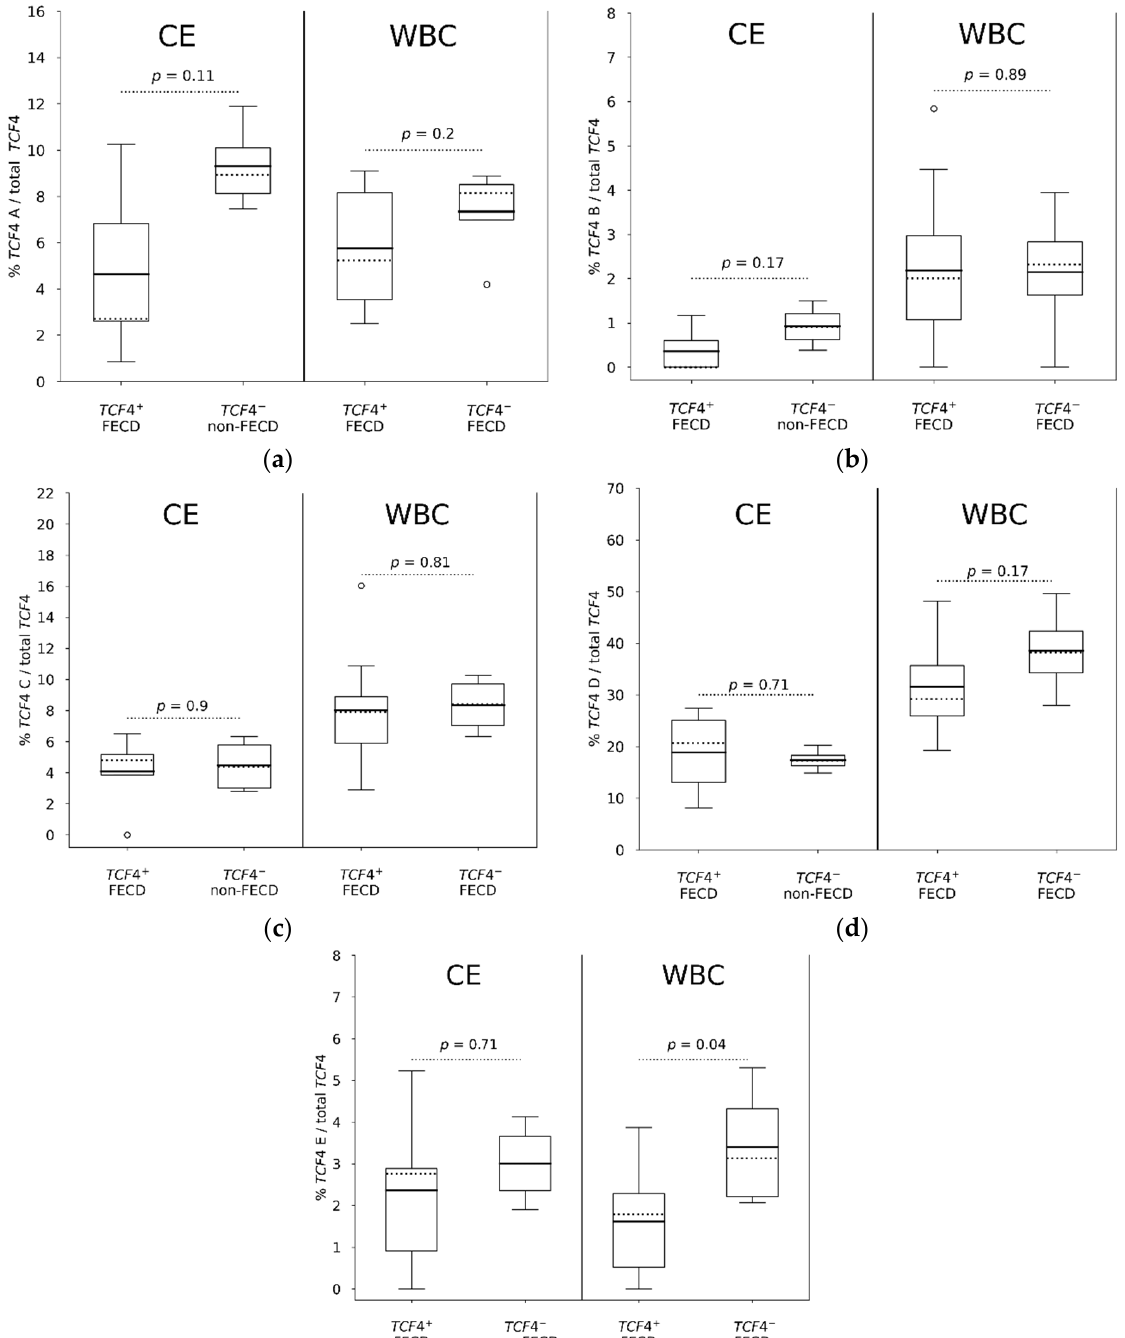
Figure 4. mRNA gene expression probed by TaqMan TM assays A to E in corneal endothelium and WBC targeting TCF4 transcripts spanning over the CTG18.1 ( a – d ) and TCF4 transcripts starting immediately at the 3 ′ end of the (CTG) n repeat tract ( e ). Within boxes, dotted lines display medians and continuous lines display means. Empty circles display outliers. TCF4 + —individuals harbouring TCF4 (CTG) n with more than 40 repeats ( n > 40), TCF4 − —individuals harbouring TCF4 (CTG) n with less than 40 repeats ( n < 40). CE—corneal endothelium, WBC—white blood